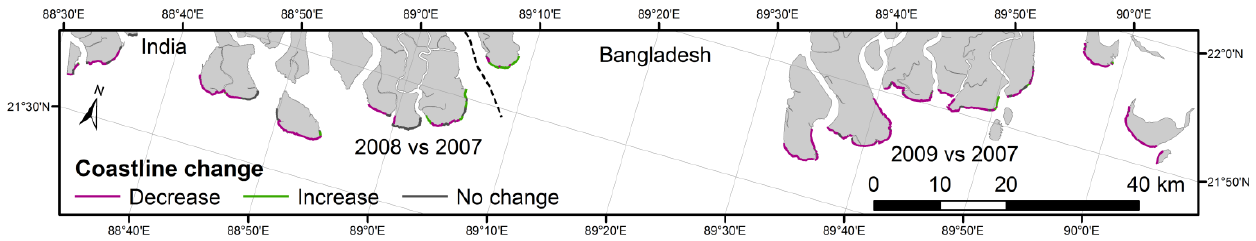
Figure 4. Coastline retreat assessment showing the change for the periods 2007–2008 (for the west side of the Sundarbans) and 2007–2009 (for the east side of the Sundarbans). The purple lines show retreating coastline; the grey line corresponds to areas of the coastline with no change; the green line corresponds to areas of the coastline where expanding coastline is